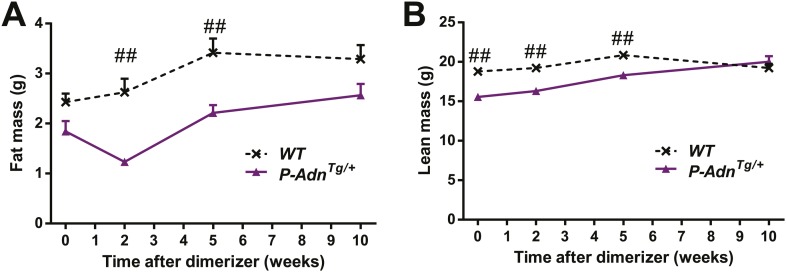
Body composition of PANIC-ATTAC mice.Fat mass (A) and lean mass (B) at 0, 2, 5, 10 weeks after initial dimerizer treatment. n ≥ 6 mice per condition. Data are presented as the mean ± SEM. #p < 0.05, ##p < 0.01 for P-AdnTg/+ vs WT. Related to Figure 5B.